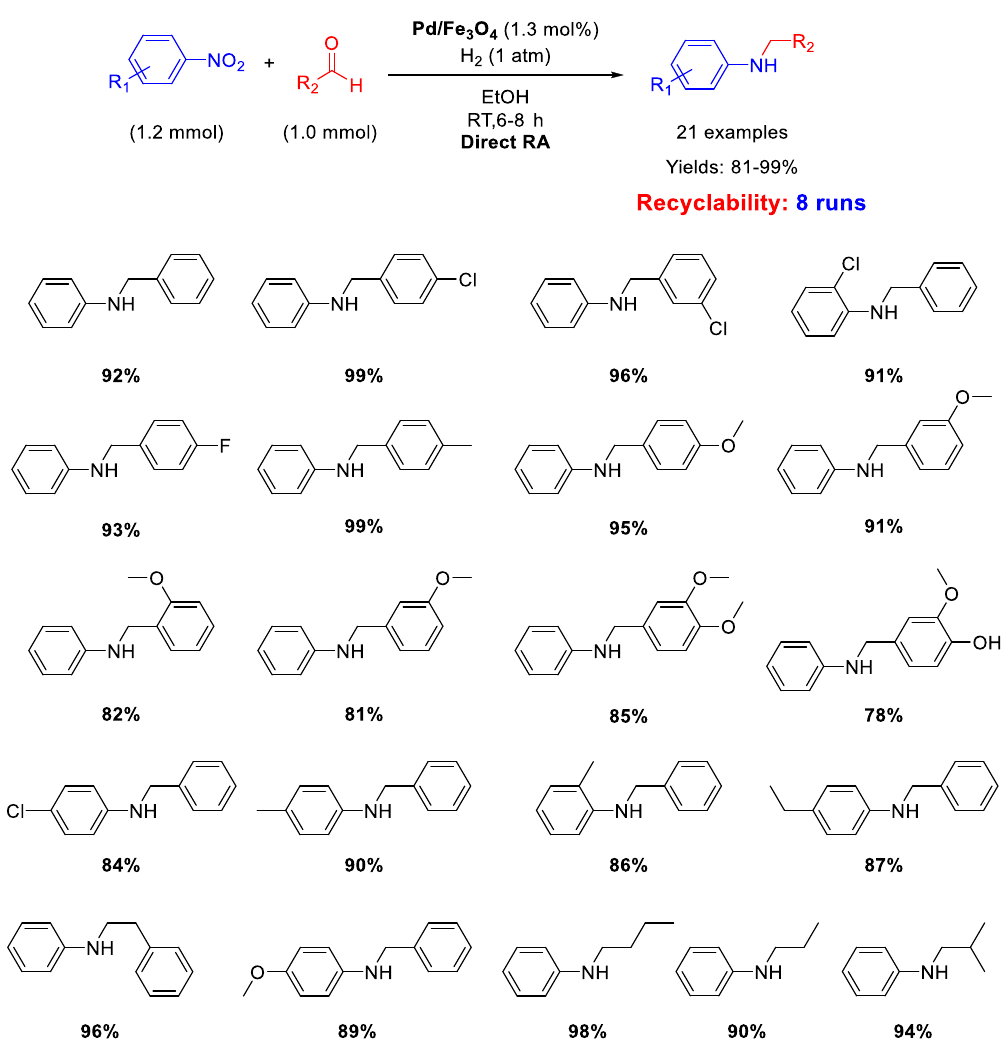
Scheme 14. DRA catalyzed by Pd/Fe 3 O 4